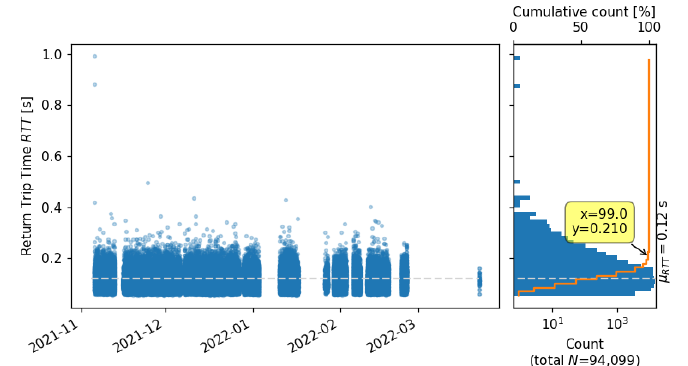
Figure 7. Block diagram of the system implementation.